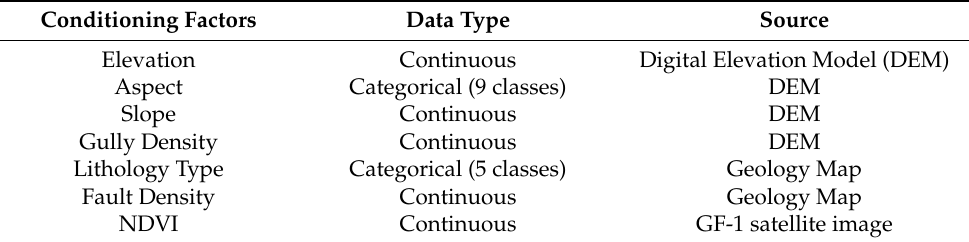
Table 1. Data used in the